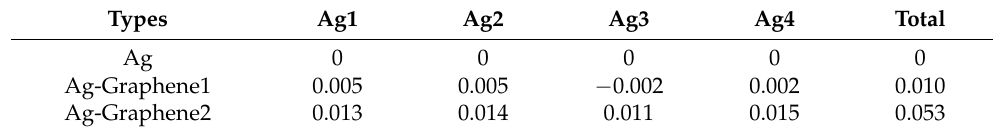
Table 1. Charge distribution of three types of silver electrode plates (Unit: e).